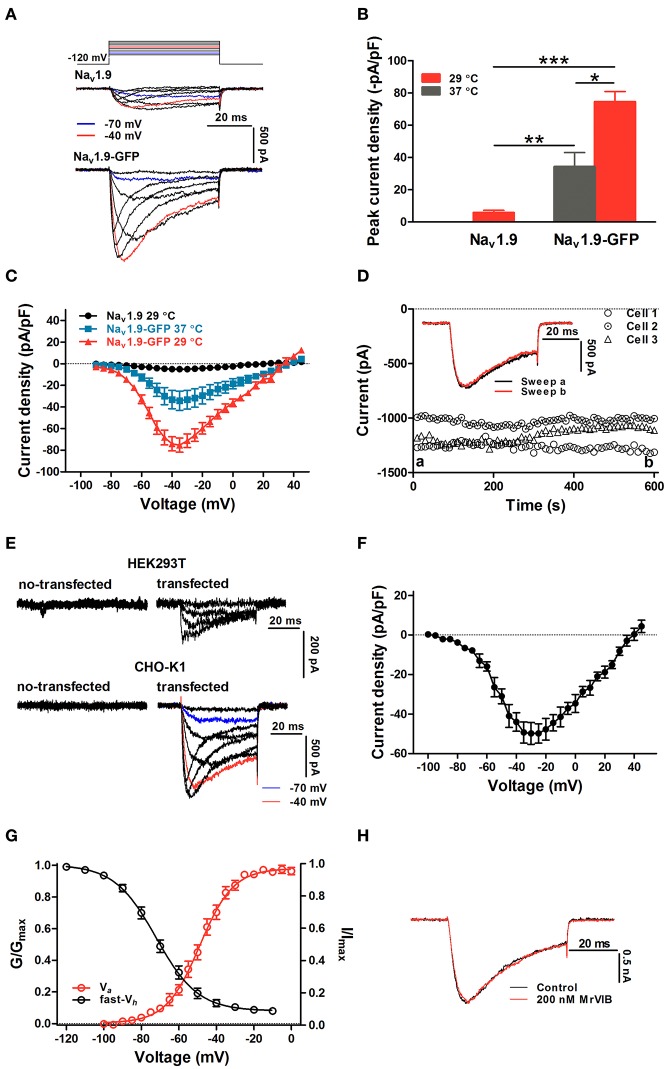
Functional expression and characterization of hNav1.9 in heterologous cells. (A) Representative inward currents of hNav1.9 or hNav1.9-GFP transiently transfected in ND7/23 cells cultivated at 29°C. Currents were evoked by depolarization from a holding potential of −120 mV up to −10 mV in 10-mV steps. Note that the data were recorded 5 min after establishing whole-cell configuration. (B) Comparison of peak current densities of hNav1.9 and hNav1.9-GFP in ND7/23 cells cultivated at 37° or 29°C. *p < 0.05; **p < 0.01; ***p < 0.001. (C) Current-voltage relationships measured from channels indicated. (D) The stability of hNav1.9-GFP current in ND7/23 cells that elicited by a 50-ms depolarization to −50 mV from a holding potential of −120 mV. Data sweeps were acquired at 0.1 Hz. The inset shows representative current traces before (sweep a) and after (sweep b) a 10-min recording. (E) Representative current traces in HEK 293T (upper) or CHO-K1 (below) cells transfected with hNav1.9-GFP. Currents were activated by depolarizing up to −10 mV in 10-mV steps from a holding potential of −120 mV. (F) Current density-voltage relationship of hNav1.9 in CHO-K1 cells. The cells were held at −120 mV and stepped to potentials of −100 to +40 mV in 5-mV increments for 50-ms every 5-s. (G) The steady state activation and inactivation of hNav1.9 in CHO-K1 cells. Data points were well fitted with the Boltzmann equation. Voltage-dependent activation was derived from the data in (F). Voltage-dependent steady-state fast inactivation of hNav1.9 in CHO-K1 cells was measured with a series of 1,000-ms prepulse (−120 to −10 mV in 10-mV increments), followed by a 50-ms depolarization to −40 mV to assess the available non-inactivated channels. (H) During pre-incubated with MrVIB 2 min, MrVIB had no effect on the hNav1.9-GFP current in ND7/23 cells. The current was activated by a 50-ms depolarization of −40 mV from the holding potential of −120 mV. 1 μM TTX were applied in all experiments.